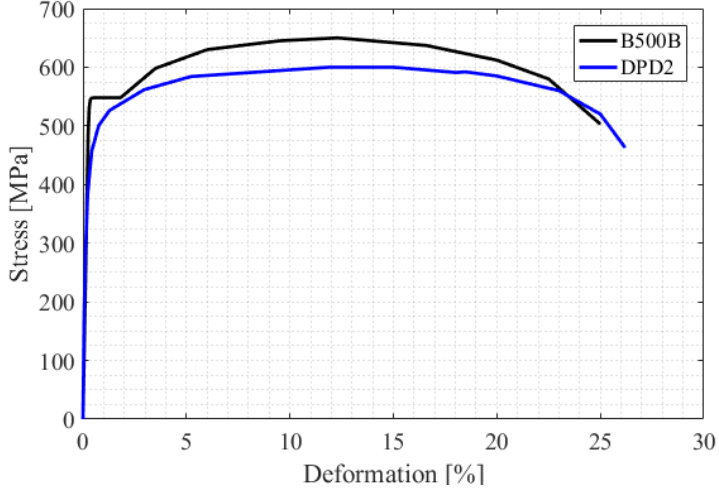
Figure 1. Stress-strain relationships of B500B and DPD2 steel grades.